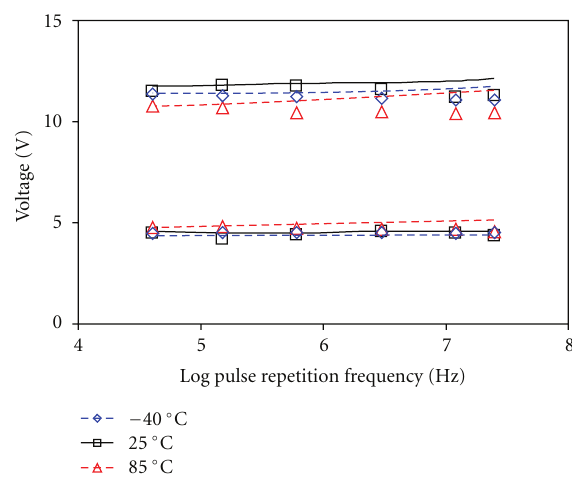
Figure 10: Measured output pulse amplitudes under di ff erent temperature as functions of pulse-repetition frequency between 40kHz and 25 MHz. From the bottom up, the biases for pulse generator are VCC1 = 3.3 V, VCC2 = 3.3 V, and VCC3 = 14V and VCC1 = 3.3 V, VCC2 = 3.3 V, and VCC3 = 6 V.